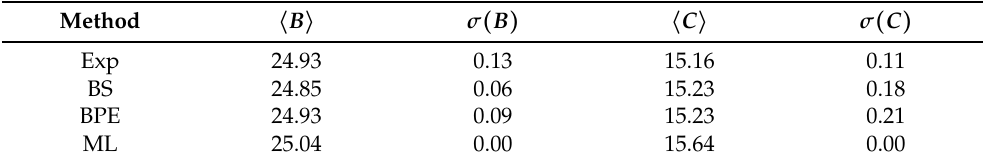
Table 3. Mean values (cid:104) B (cid:105) , (cid:104) c (cid:105) , standard deviations σ B , σ C for experimental values (Exp), and calcu- lations from the Bayesian predictive ensemble (BPE) and the simple estimates from the bootstrapped models (BS). The results of the best ML model for a singular prediction of (cid:104) B (cid:105) (full GP model) and (cid:104) C (cid:105) (full LR model) are also